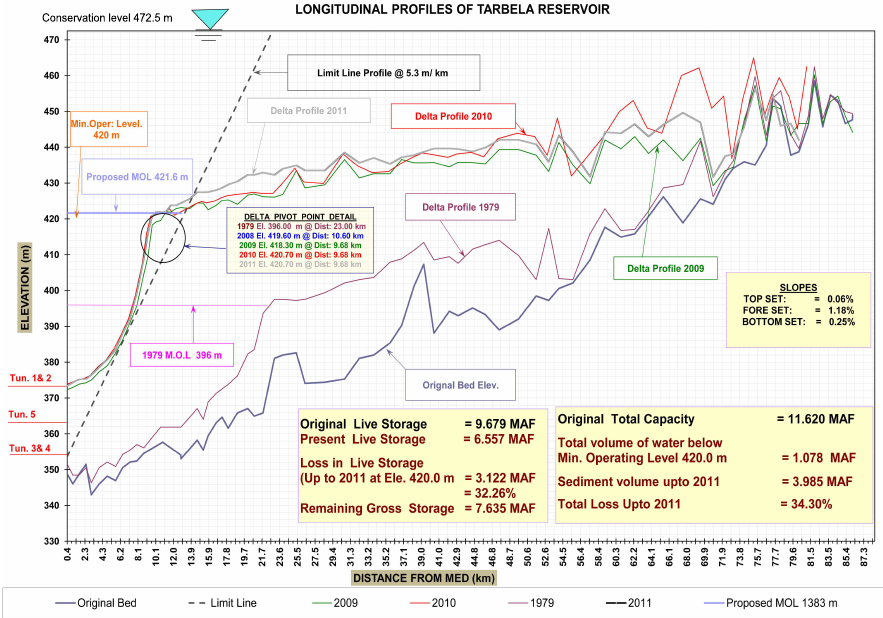
Figure 2. Sediment delta development in the Tarbela dam.